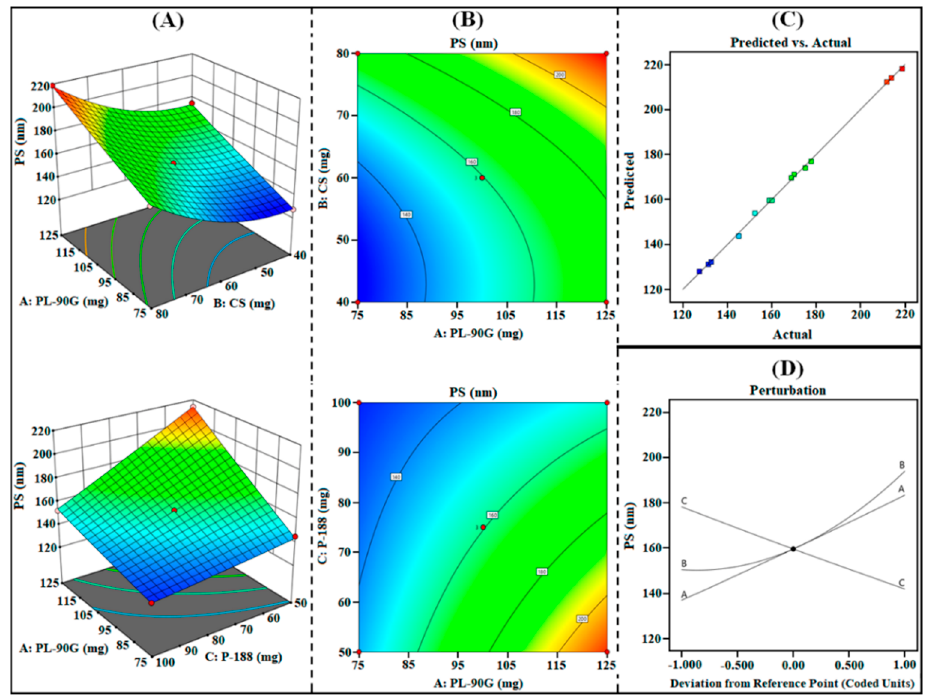
Figure 2. Image representing 3D response surface plots ( A ), contour plots ( B ), predicted vs. actual plot ( C ), and perturbation plot ( D ) representing the influence of independent factors (A = PL-90G; B = CS; C = P-188) on R 1 (PS) for PPN-LPHNPs.